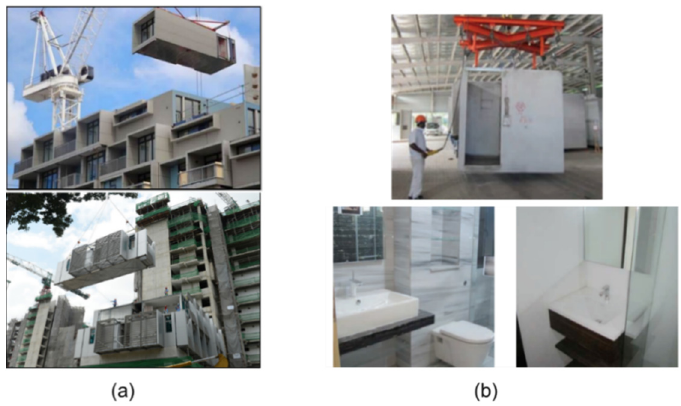
Figure2. PrefabricatedhousingunitsinSingapore: ( a )prefabricatedprefinishedvolumetricconstruction (PPVC) and ( b ) prefabricated bathroom unit